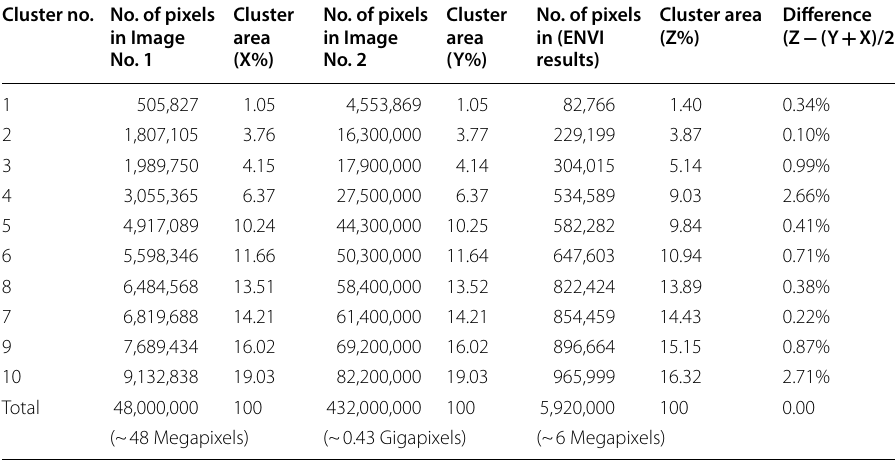
Table 7 Comparing the number of pixels for the important clusters Cluster no. No. of pixels in